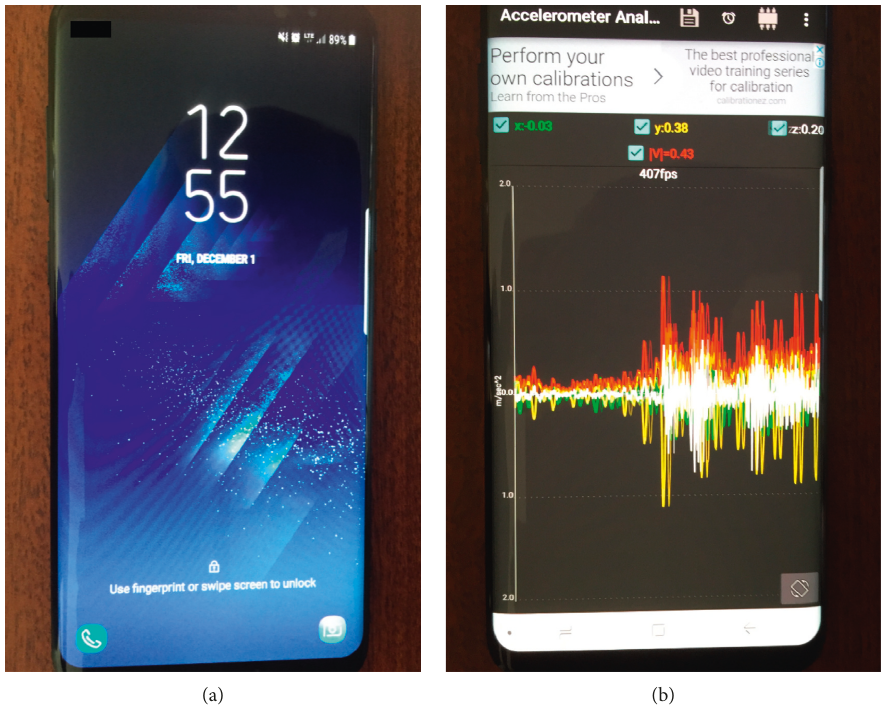
Figure 3: Samsung Galaxy S8+: (a) general view; (b) App used for acceleration measurement.